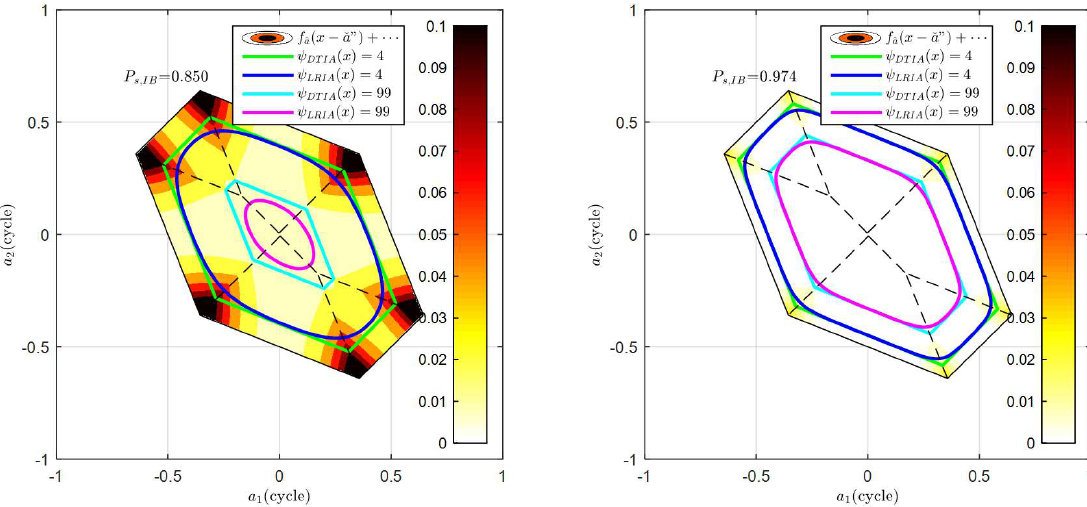
Figure 2. Demonstration of the acceptance region difference between the OIA and the DTIA with weak model (left) and strong model (right).